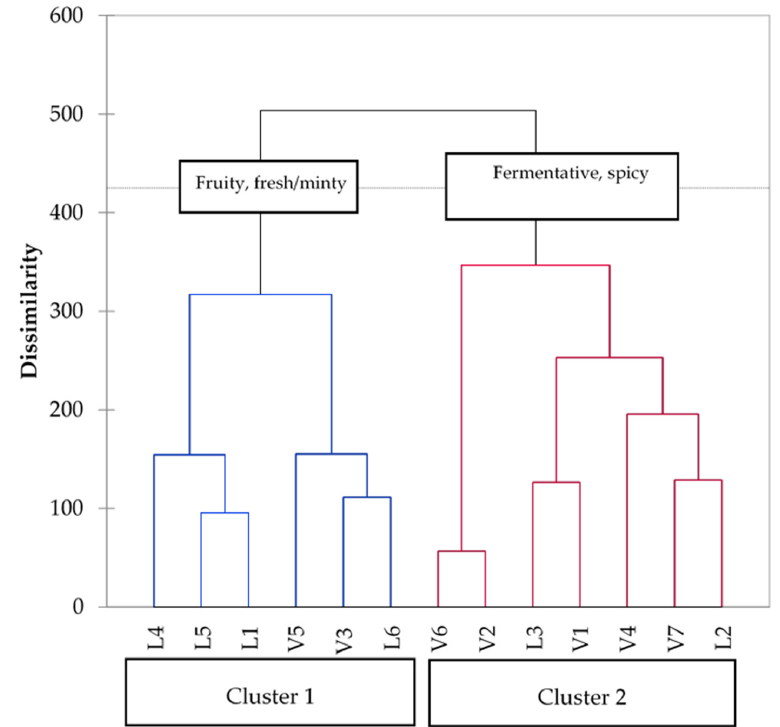
Figure 2. Dendrogram illustrating the results of Lugana and Verdicchio wines sorting task. The dashed line indicates the significance threshold. The blue lines represent Cluster 1 , the red lines represent Cluster 2 .